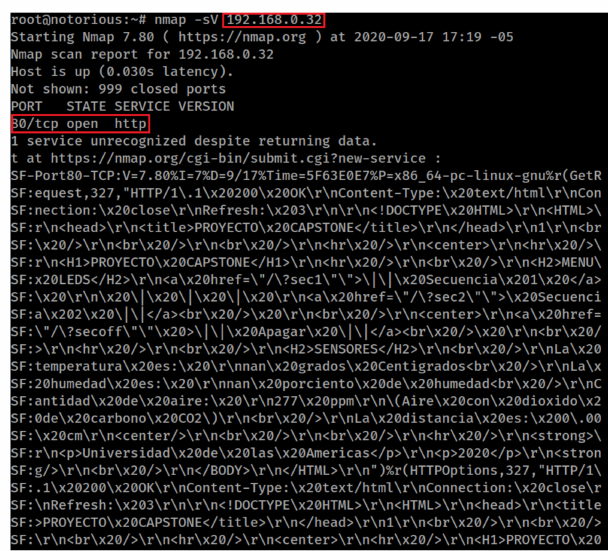
Figure 11. Ports